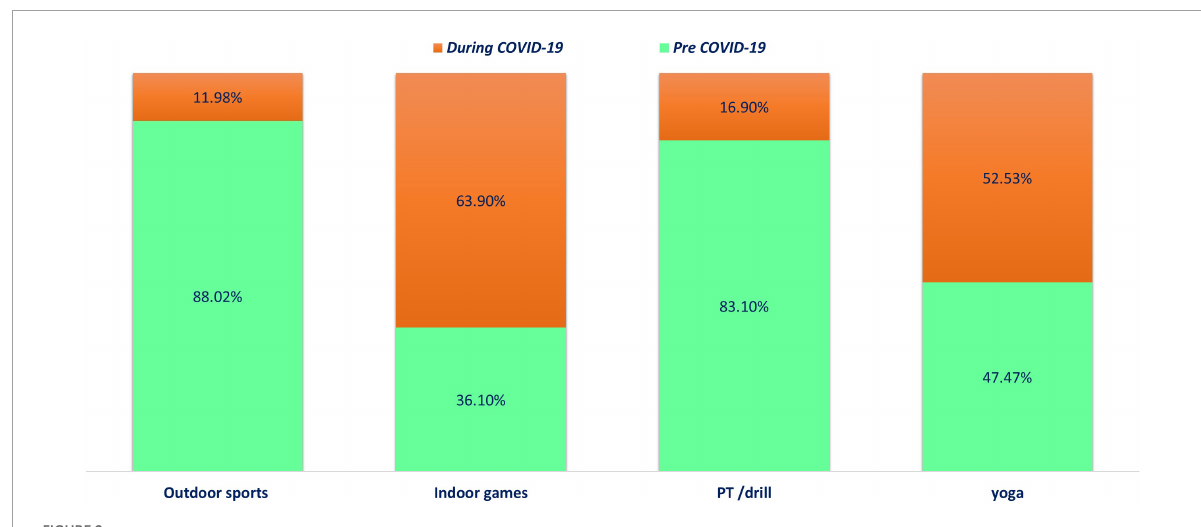
( p = 0.000), and PT/drill ( p = 0.000) before and during